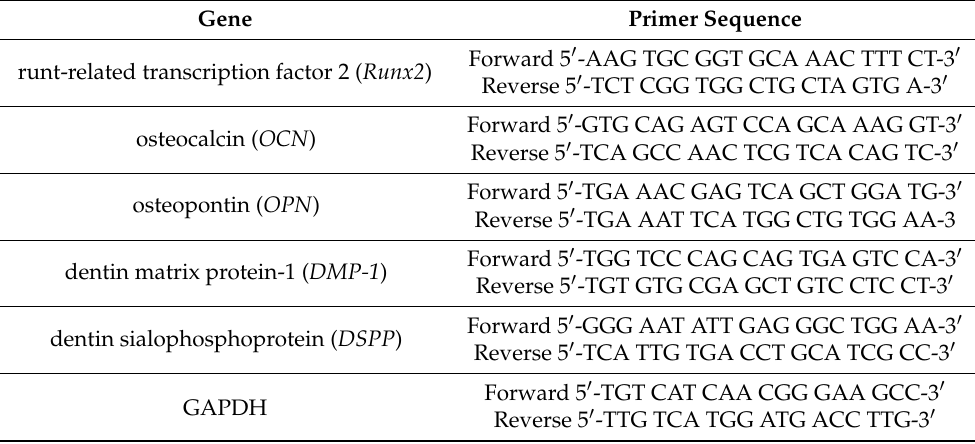
Table 2. Primer sequences for evaluating osteogenic gene expression in hDPSCs.